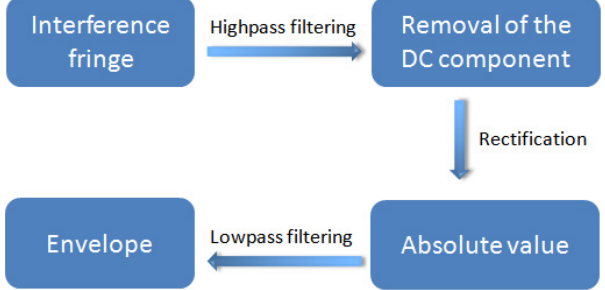
Fig. 2. Diagram of the TD-OCT post-processing algorithm.